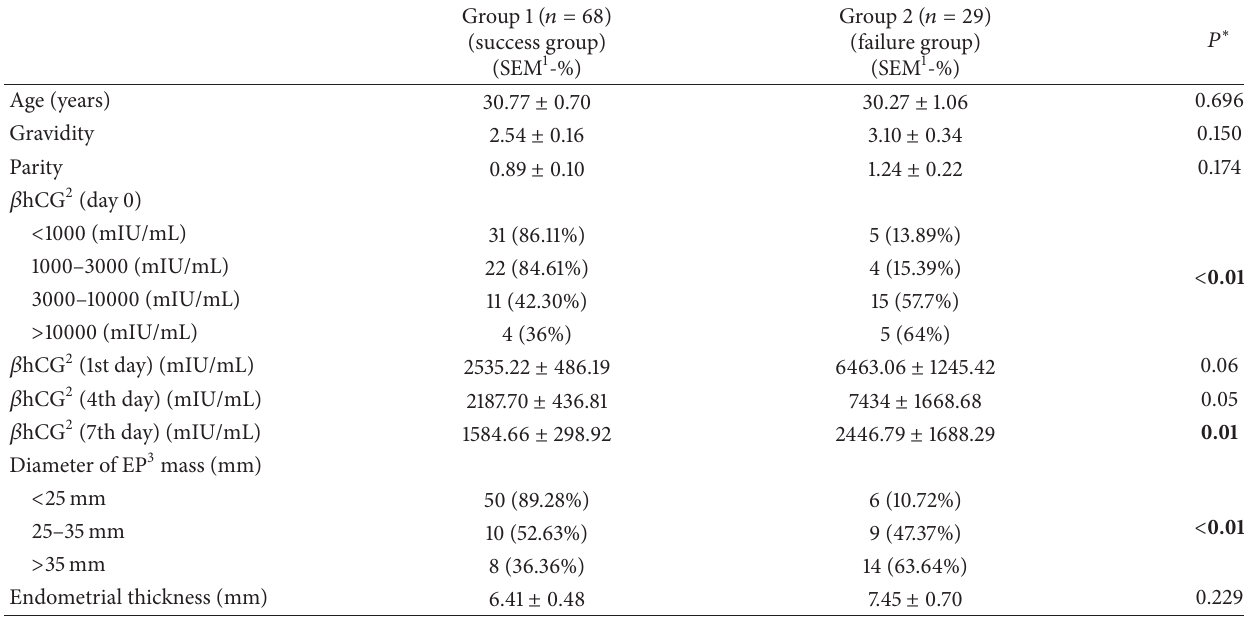
Table 3: Demographic and clinical characteristics of all patients treated with Mtx in